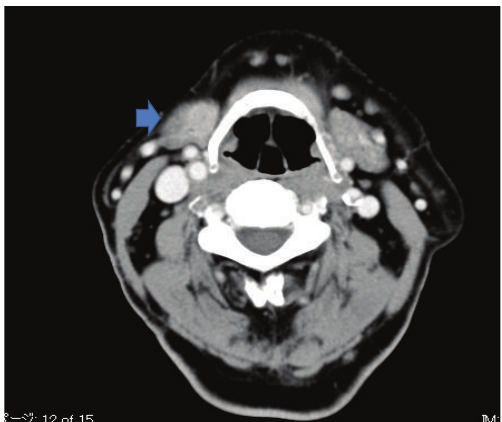
Figure 1: Neck CT showing a 20 mm × 10mm nodular shadow with slight enhancement in the right submandibular area.